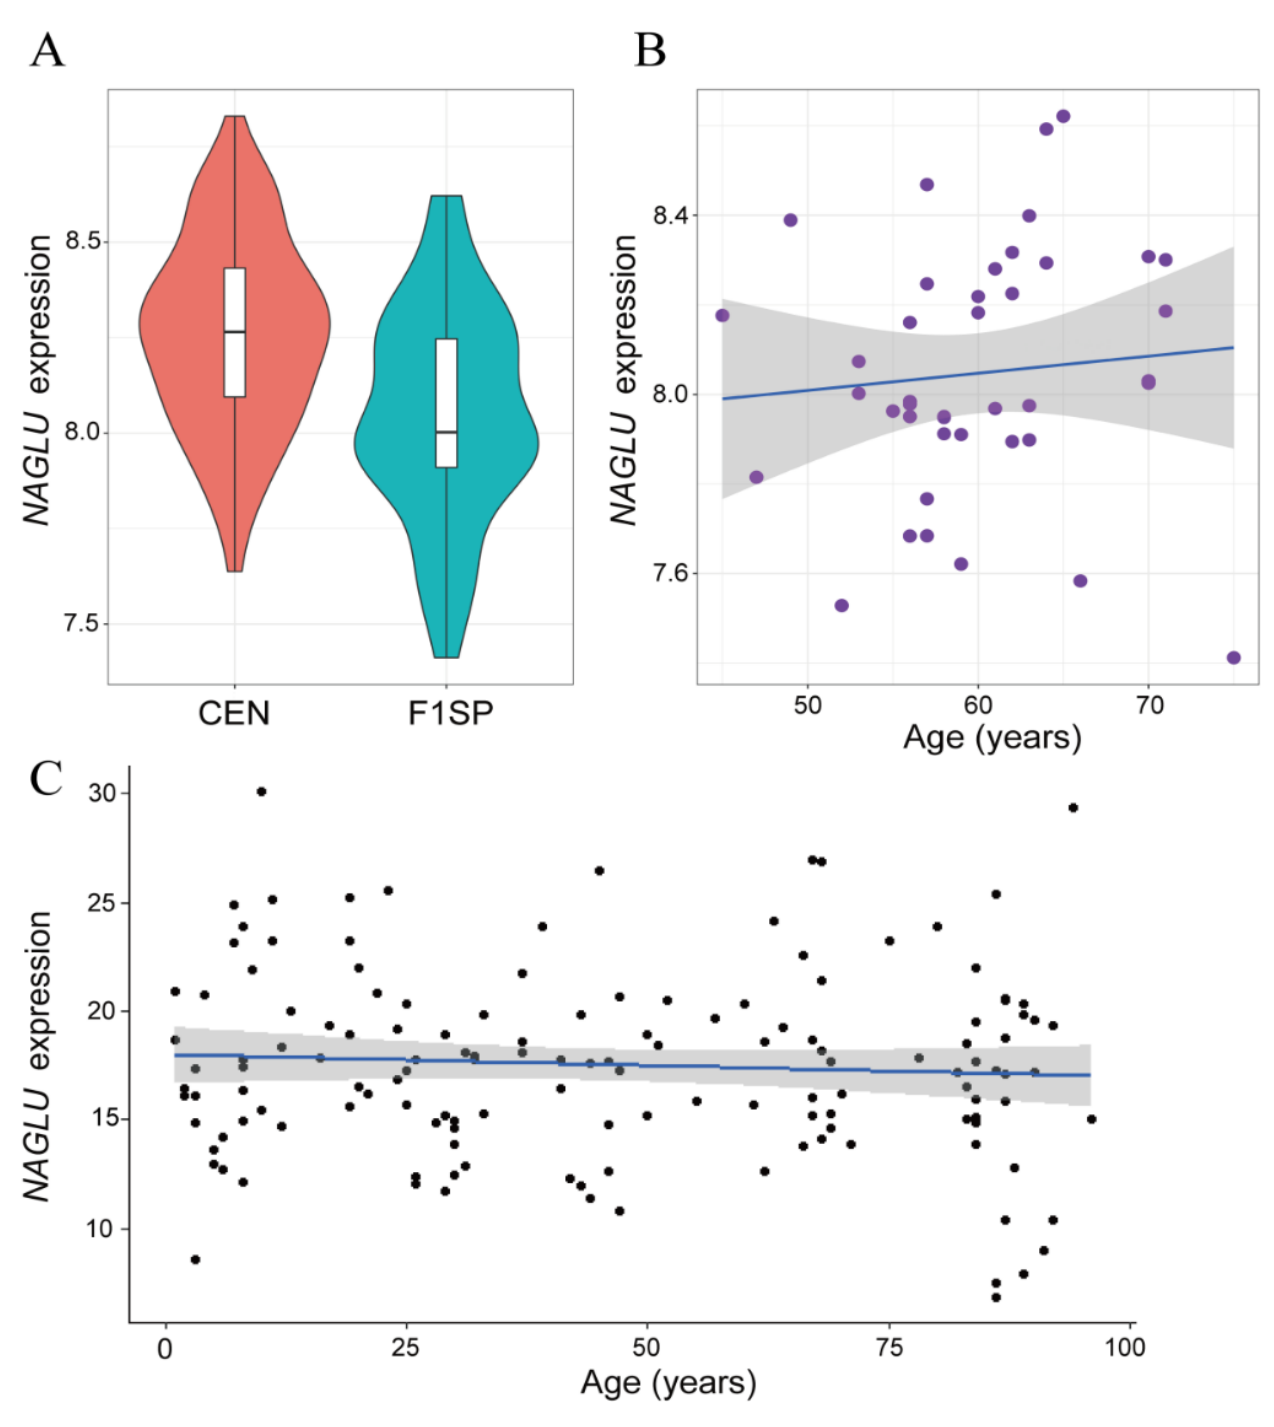
Figure 1. Expression patterns of NAGLU in CEN families and in general population: ( A ) Average expression of NAGLU in CENs and in F1SPs, p = 0.0002; ( B , C ) Pearson correlation test between NAGLU expression and age in F1SP samples, p = 0.5768 ( B ) and in general population, p = 0.4064 ( C ).